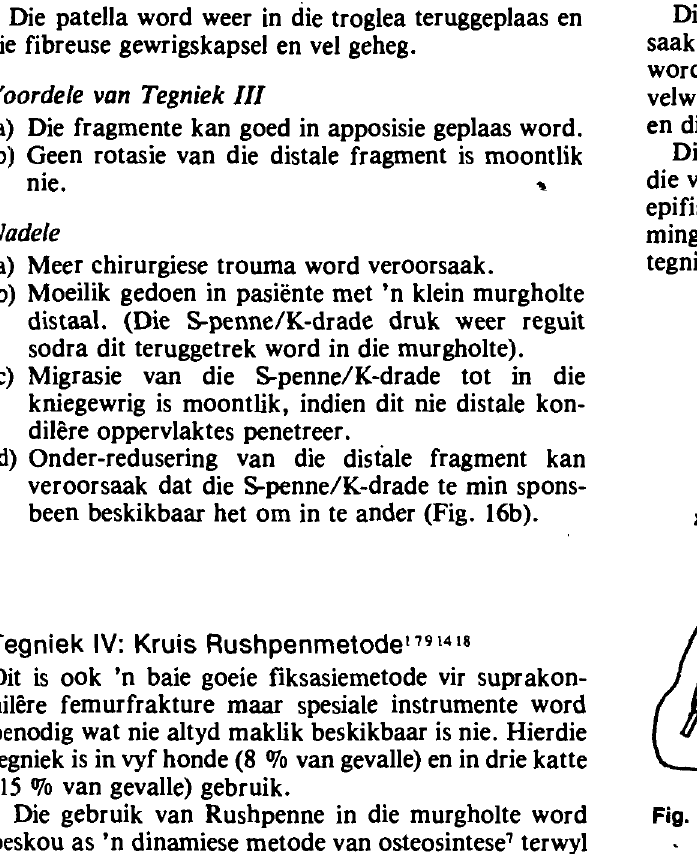
Fig. 18: Kruis Kirschnerdraad kompressiemetode: Kirschnerdrade (b) fikseer die. fraktuur, terwyl die figuur agt drade (a) drukking op die fraktuurlyn veroor saak.